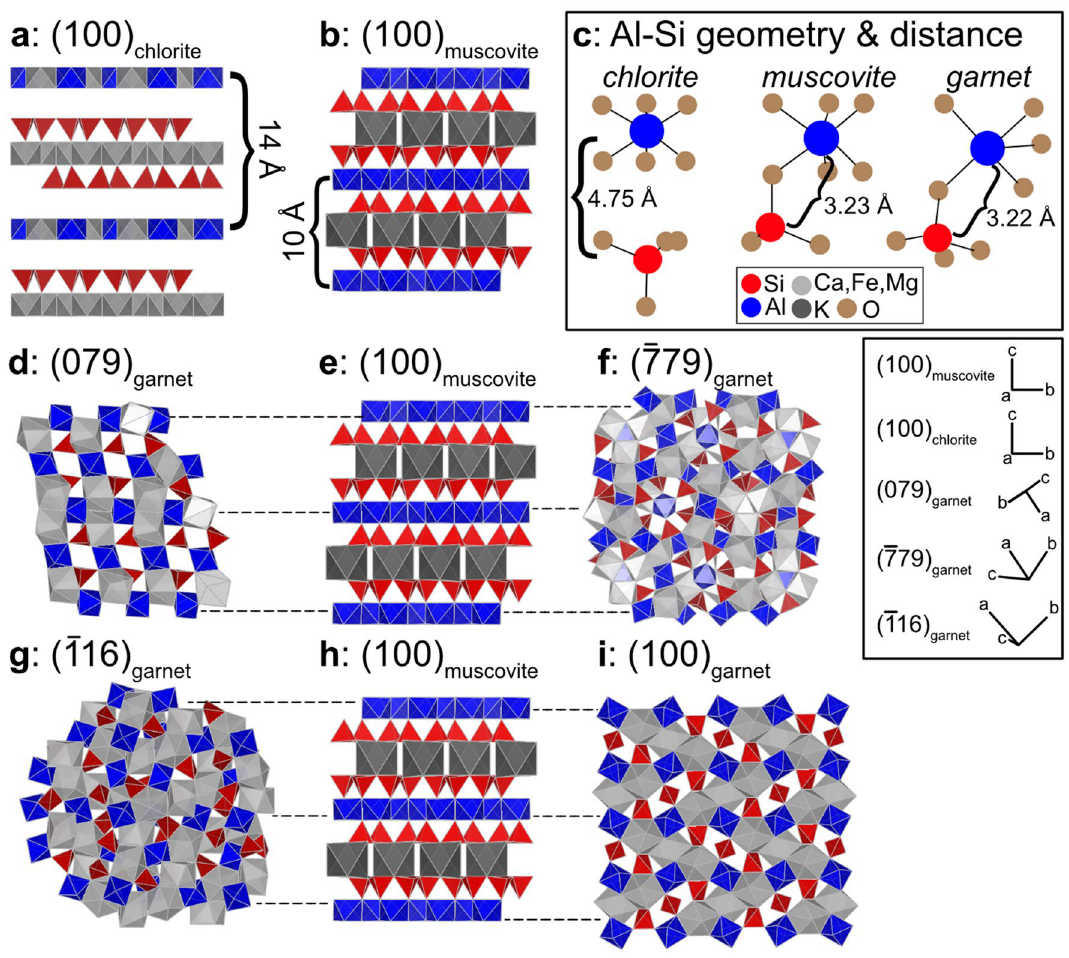
Figure 4. Crystal structure models of ( a ) chlorite 48 and ( b ) muscovite 30 . ( c ) Al octahedra–Si tetrahedra geometries and distances in chlorite, muscovite, and garnet. ( d – i ) Crystal structure models of (0 7 9) gt, (100) ms , − − 7 7 9 ) 1 16 ) ( gt, ( gt , (1 0 0) ms , and (1 0 0) gt , with dashed lines highlighting relationships between Al in each. The inset shows the 3D orientation of all of the crystal planes. sub-parallel in these samples (Supplemental Figs. S3–7), so inheritance of garnet orientation from muscovite Distance between Al Distance between Al-Al distances Si–Si distances along the ‘rows’ Si ‘rows’ along the row row Si–O–Al